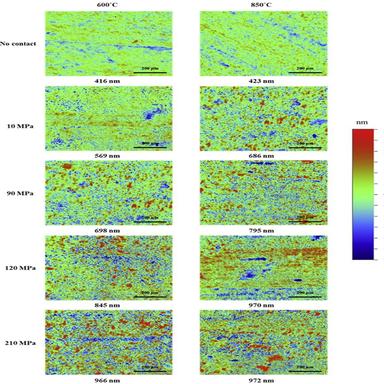
The surface roughness of the Ti-6Al-4V at different pressures and temperatures.